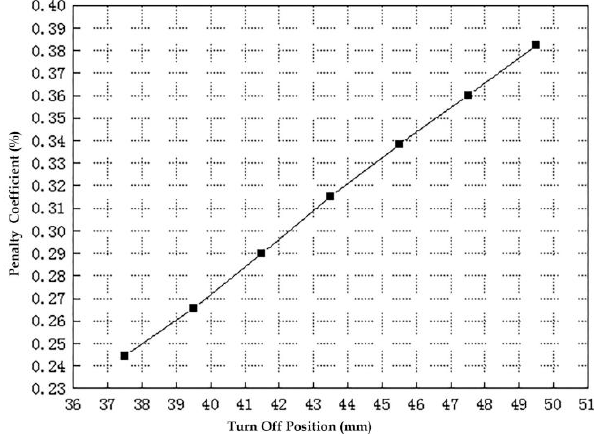
Figure 15. The distribution of the optimal penalty coefficient in the turn-off location is shown in Figure 15. The larger the turn-off position is, the larger the penalty coefficient is.